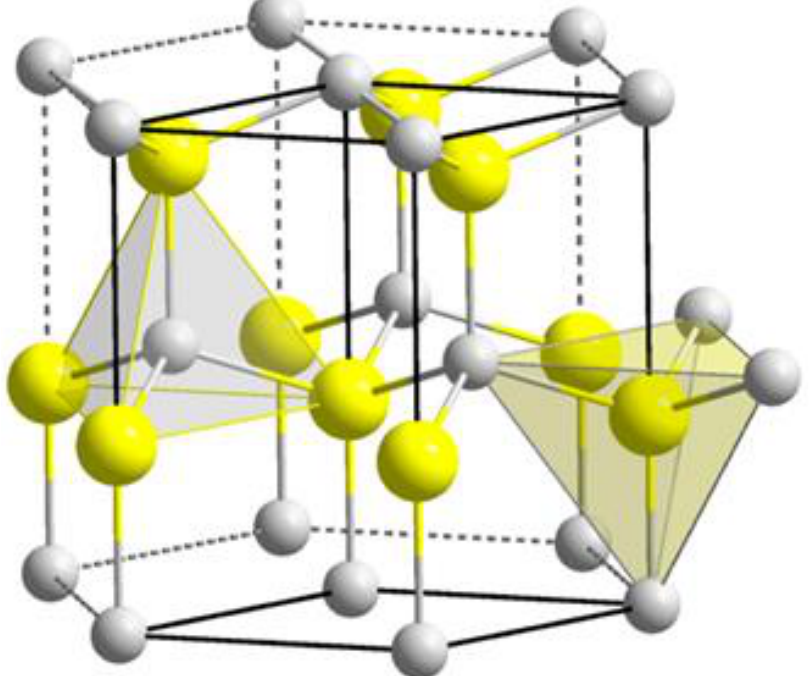
Figure 4. ZnO ionic alignments in a wurtzite crystal structure, Adapted from Ref. [30]. Yellow represents zinc and grey oxygen.